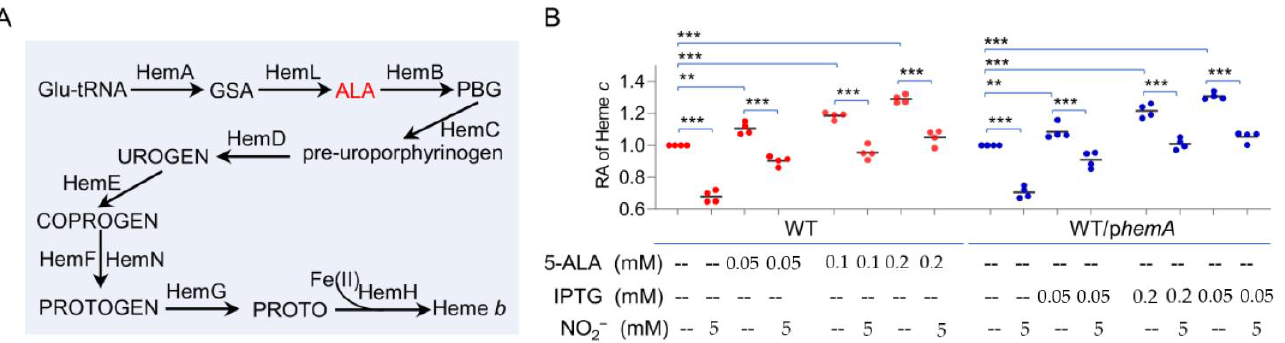
Figure 4. Heme antagonizes inhibitory effects of nitrite on the cyt c content. ( A ). Biosynthesis pathway of heme b in S. oneidensis . GSA, glutamate-1-semialdehyde; ALA, 5-aminolevulinic acid; PBG, porphobilinogen; UROGEN, uroporphyrinogen III; CORROGEN, coproporphyrinogen III; PROTOGEN, protoporphyrinogen IX; PROTO, protoporphyrin IX. ( B ). Heme c levels were quantified and are presented as relative abundance (RA). 5-ALA, the intermediate dictating the heme biosynthesis rate. Production of HemA was driven by the IPTG-inducible promoter in S. oneidensis . Asterisks indicate statistically significant difference of the values compared ( n = 4; ns, not significant; **, p < 0.01; ***, p < 0.001) .